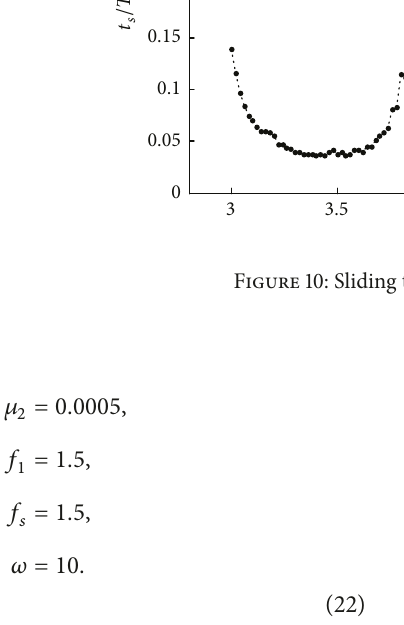
Figure 9: Sliding bifurcation.